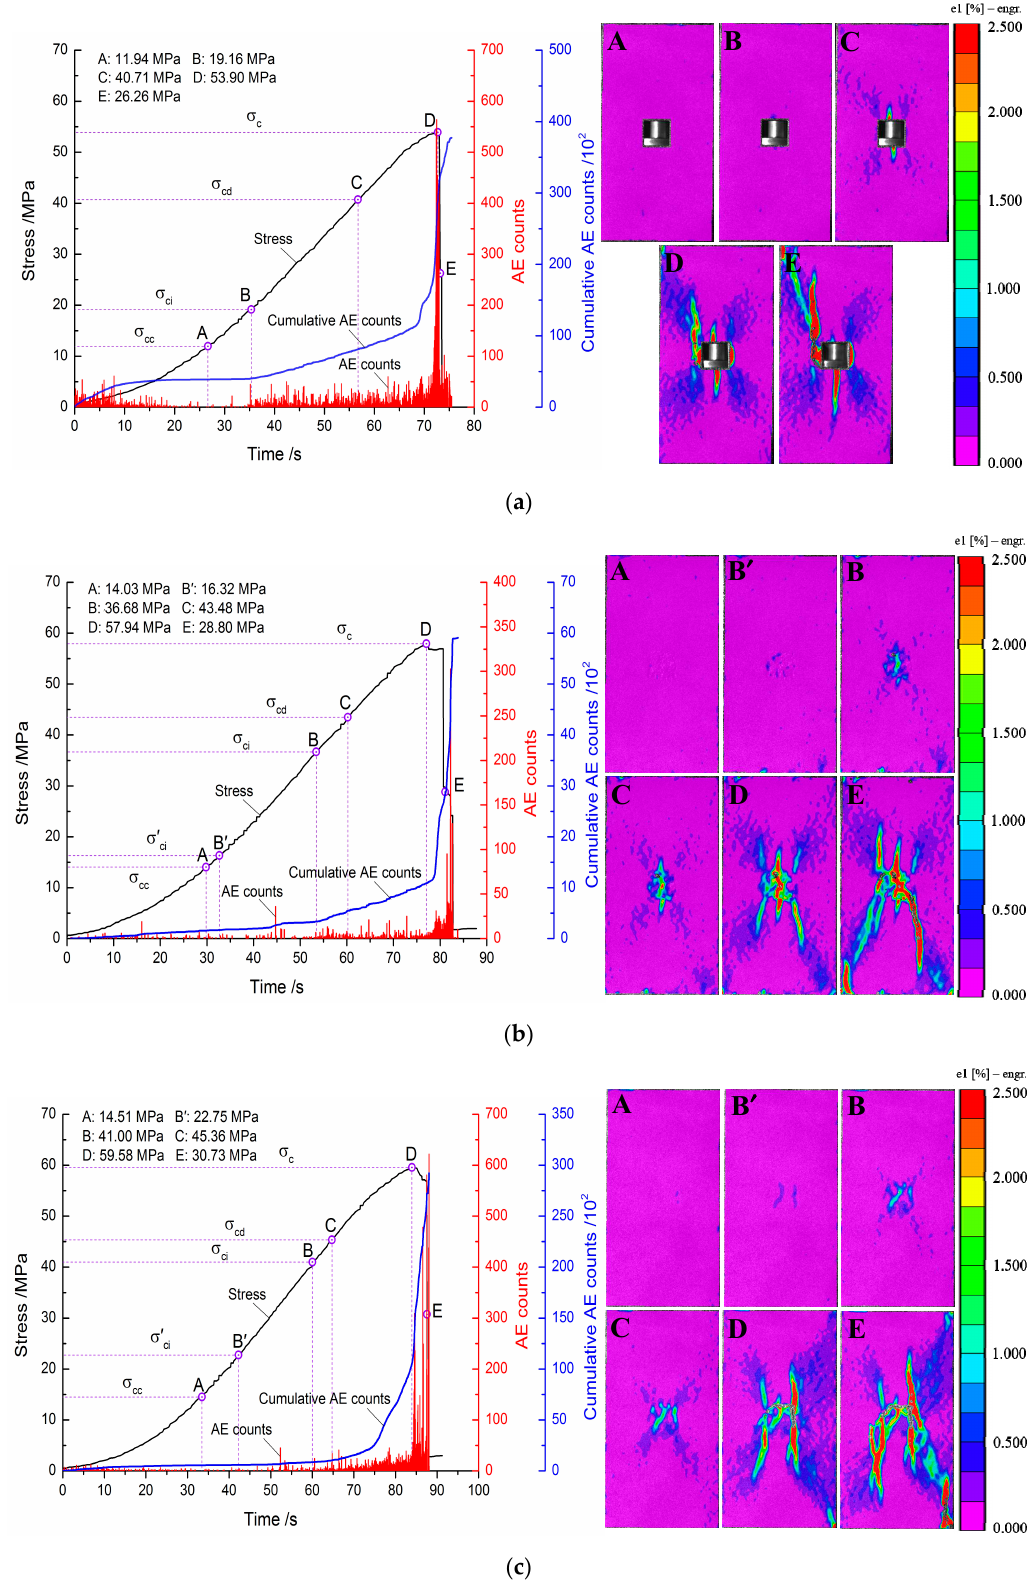
Figure 9. AE behavior and strain fields of pre-holed specimens with α = 0° under different filling modes: ( a ) Sq-0-A-1; ( b ) Sq-0-B-2; and ( c ) Sq-0-C-1.